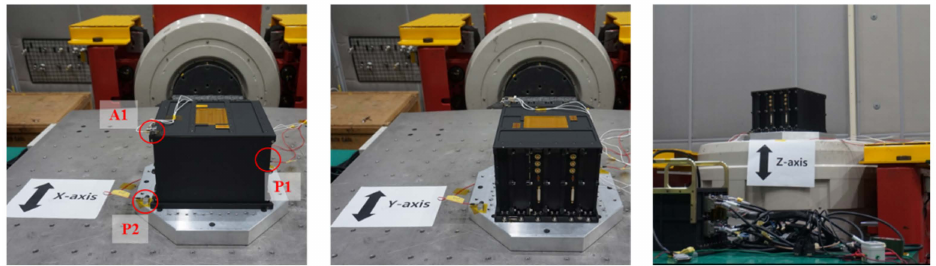
Figure 13. Vibration test configuration and accelerometer position of HSDRU. Figure 14 illustrates the dynamic responses to the random vibration test in each